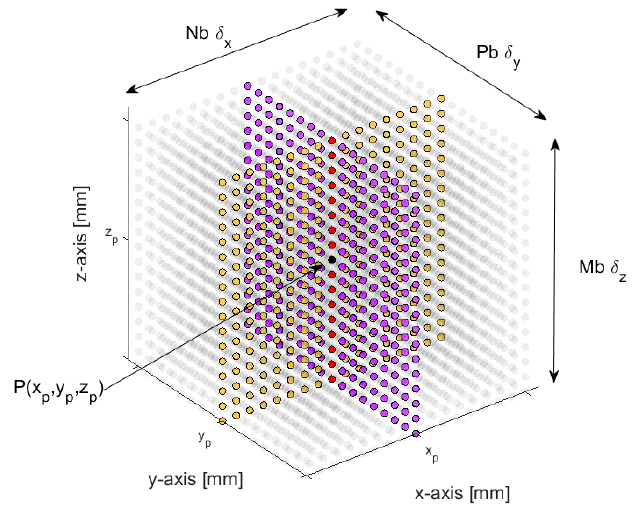
Figure 2. Example of kernel region consisting of M B × N B × P B beamformed samples, distributed according to the step distances δ z , δ x , and δ y for z, x, and y directions,